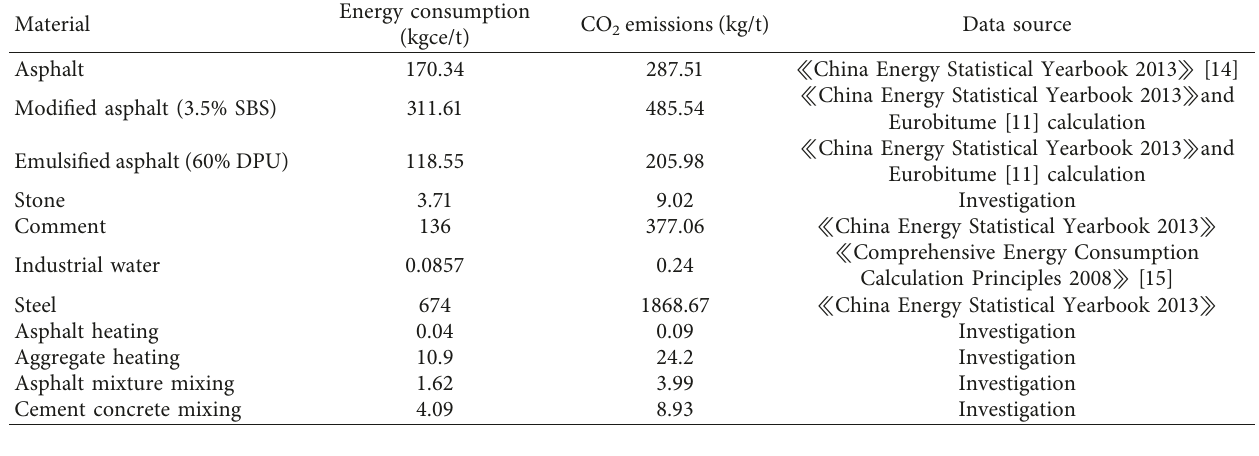
Table 4: Energy consumption and CO 2 emission of pavement materials in